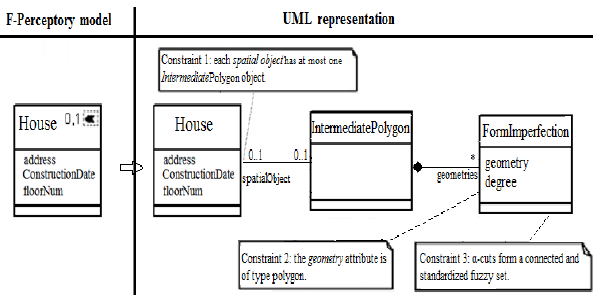
Figure 4. Fuzzy facultative polygon